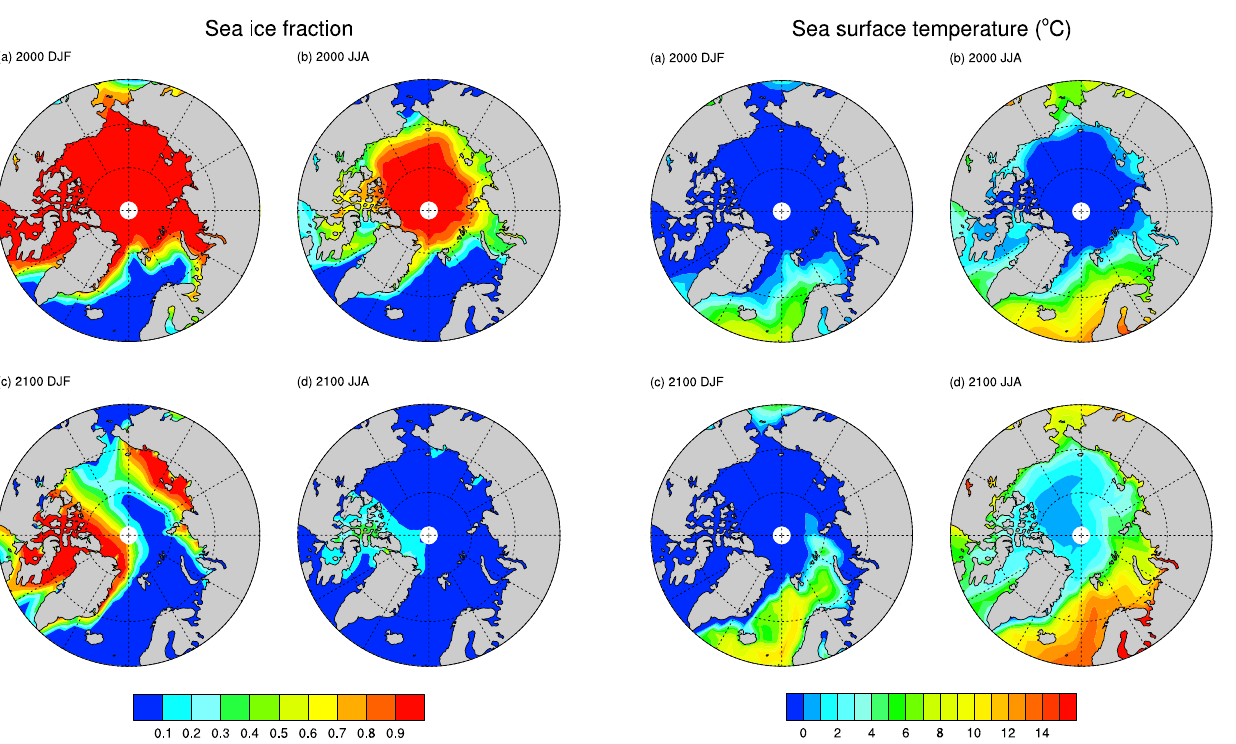
Fig. 3. Winter (DJF) and summer (JJA) sea ice fraction prescribed in the model: 2000 climatology from Hurrell et al. (2008), 2100 climatology derived using an average of three ensemble CCSM3 model simulations based on the A1B SRES scenario.